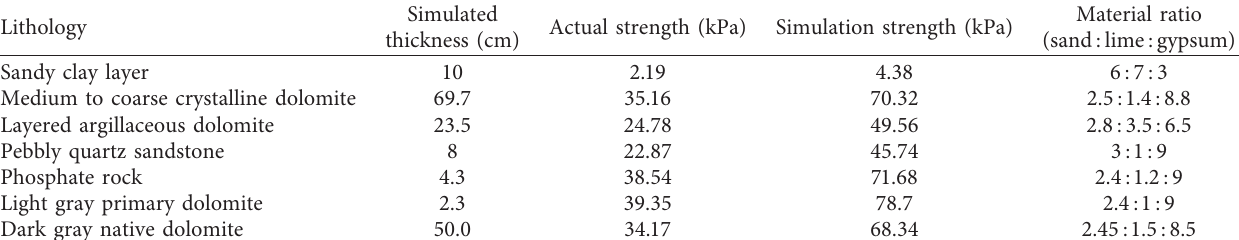
Table 2: Similar material ratio scheme.